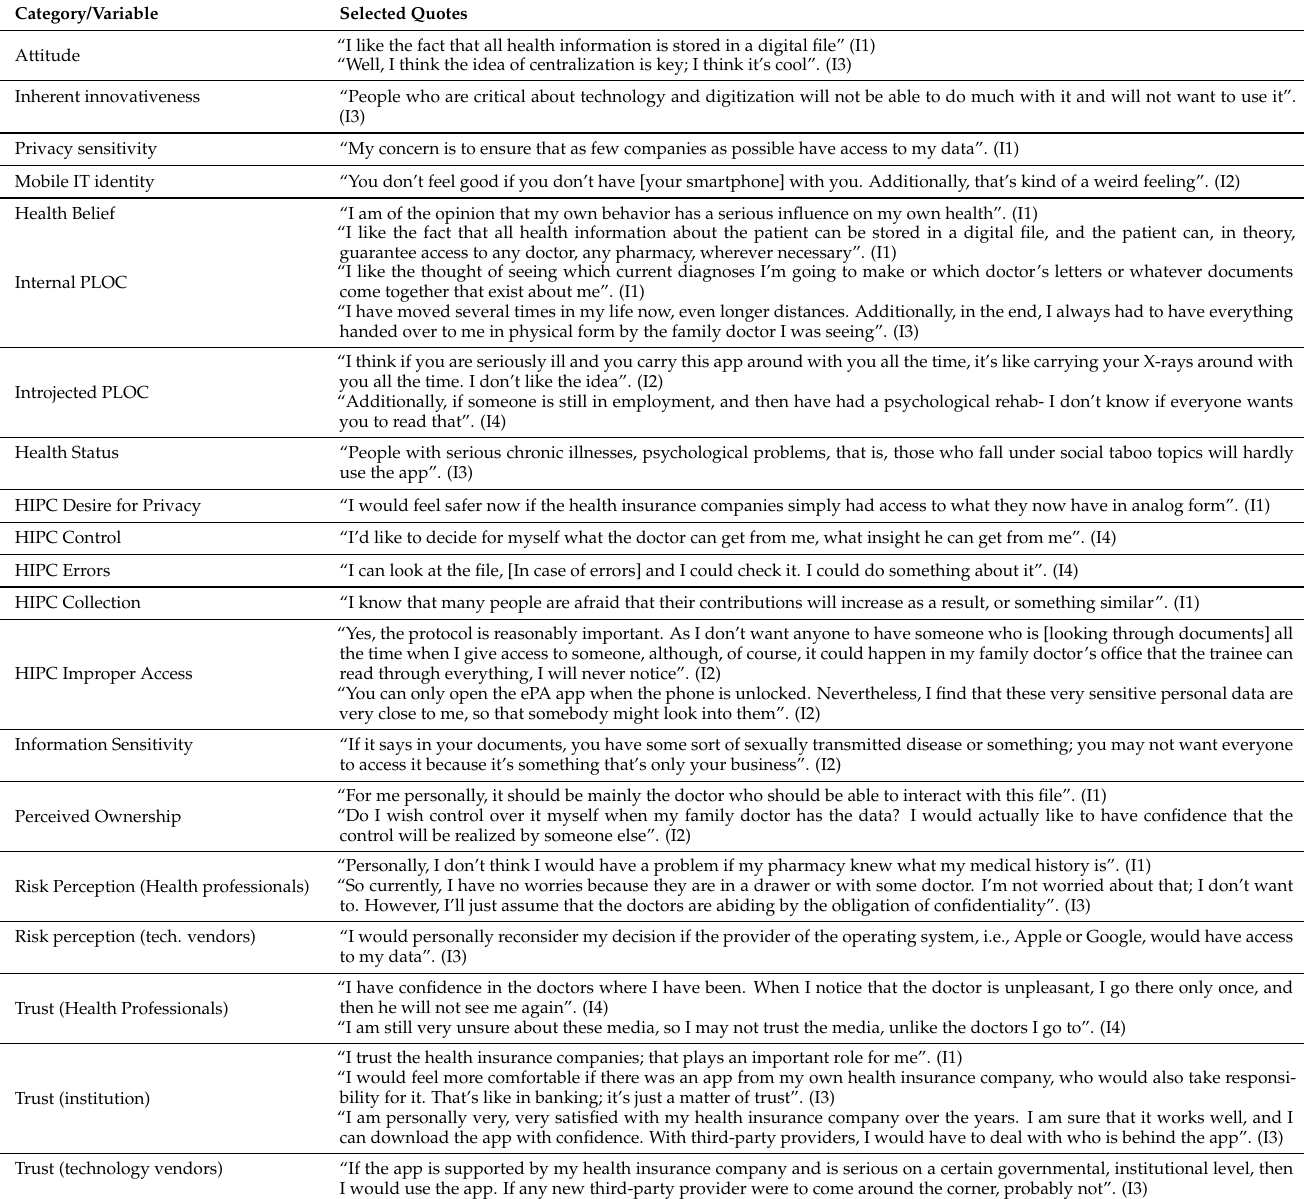
Table A4. Selected Quotes from the